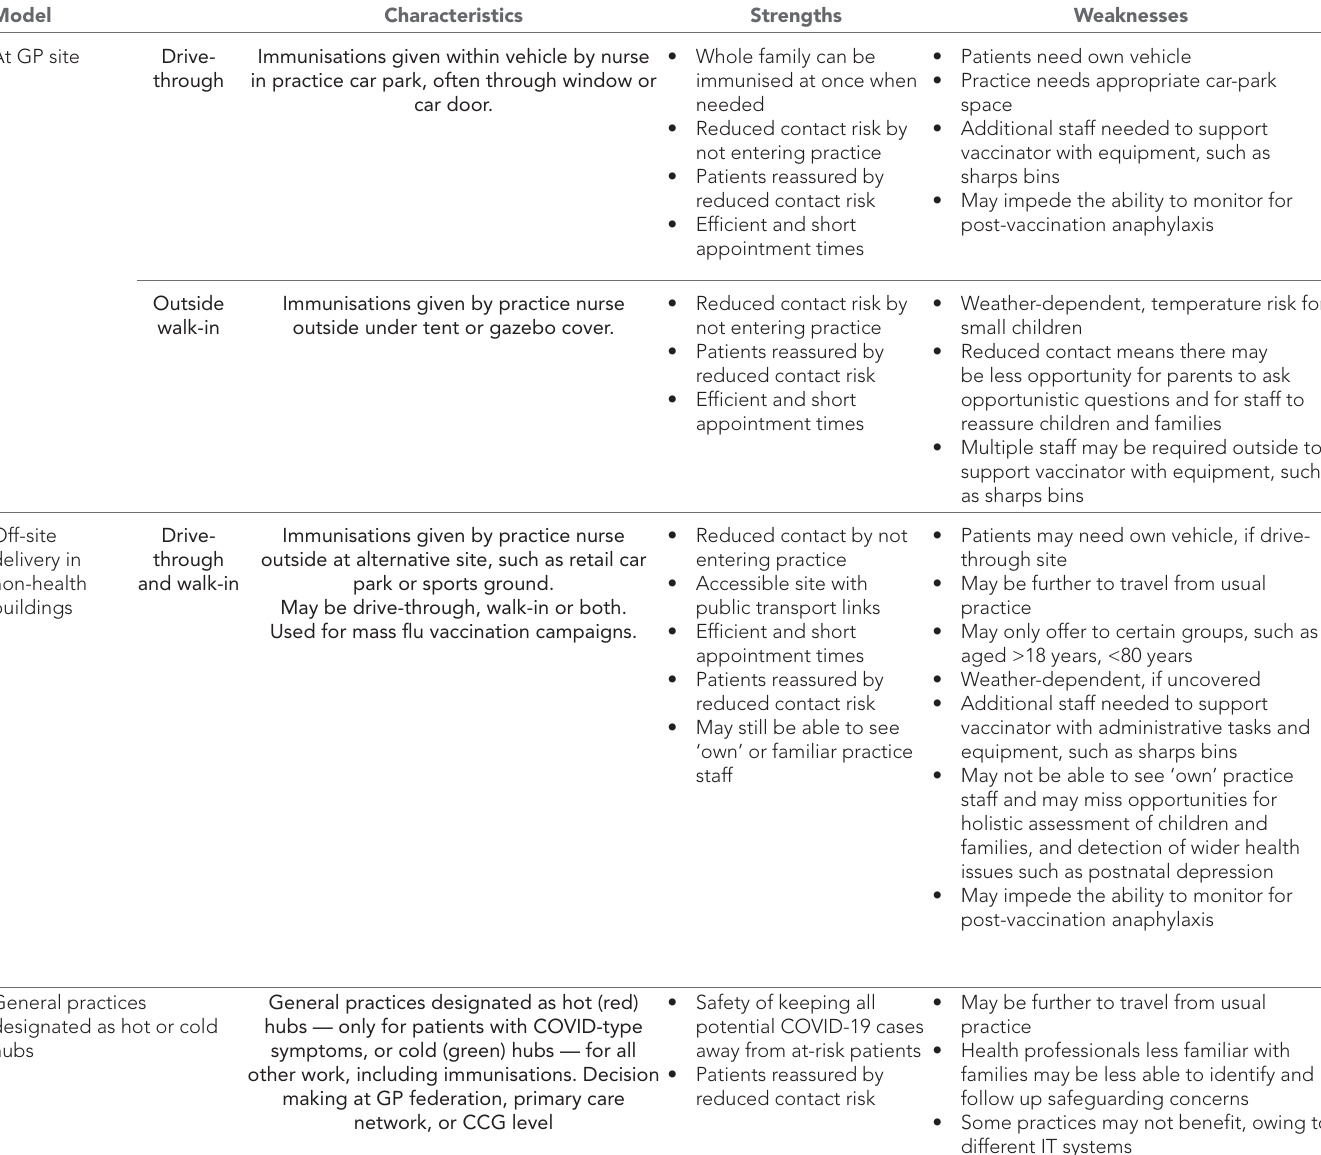
Table 3 Characteristics, strengths, and weaknesses of new delivery models and adaptations to practice